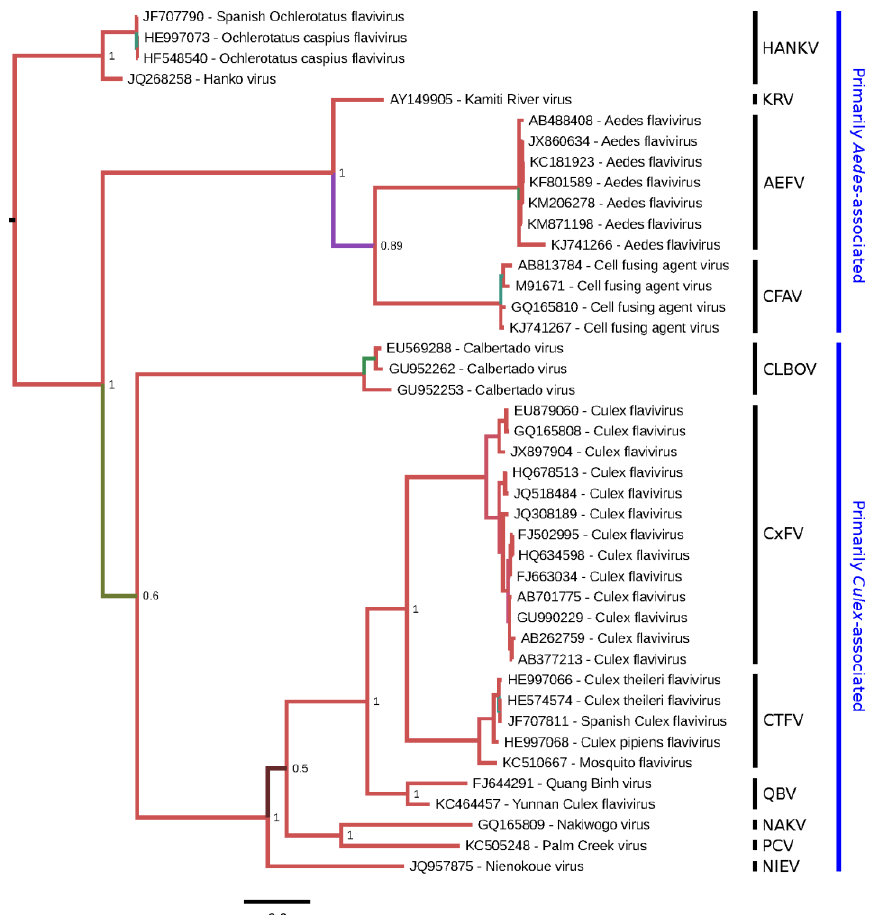
Figure 2. Phylogenetic tree for selected cISF partial NS5 sequences. A 795-nt region of NS5 corresponding to nt 8916-9710 of M91671.1 (CFAV) was used in order to include CLBOV, for which only partial NS5 sequences are available. The corresponding amino acid sequences were aligned with MUSCLE [14] and this amino acid alignment was used to guide a nucleotide sequence alignment. A maximum likelihood phylogenetic tree was estimated using the Bayesian Markov chain Monte Carlo method implemented in MrBayes version 3.2.3 [16] using the general time reversible (GTR) substitution model with gamma-distributed rate variation across sites and a proportion of invariable sites. Chains were run for 10 million generations, with the first 25% discarded as burn-in. The figure was produced using FigTree (http://tree.bio.ed.ac.uk/software/figtree/). Based on the full-genus tree (Figure 1), HANKV was selected as an outgroup to root the tree. Nodes are labelled with posterior probability values and poorly supported branches are also highlighted with alternative colors. Tips are labelled with isolate names as provided in original publications or, if unpublished, in sequence records. Species (as defined in this review) are grouped (vertical black bars) and annotated at